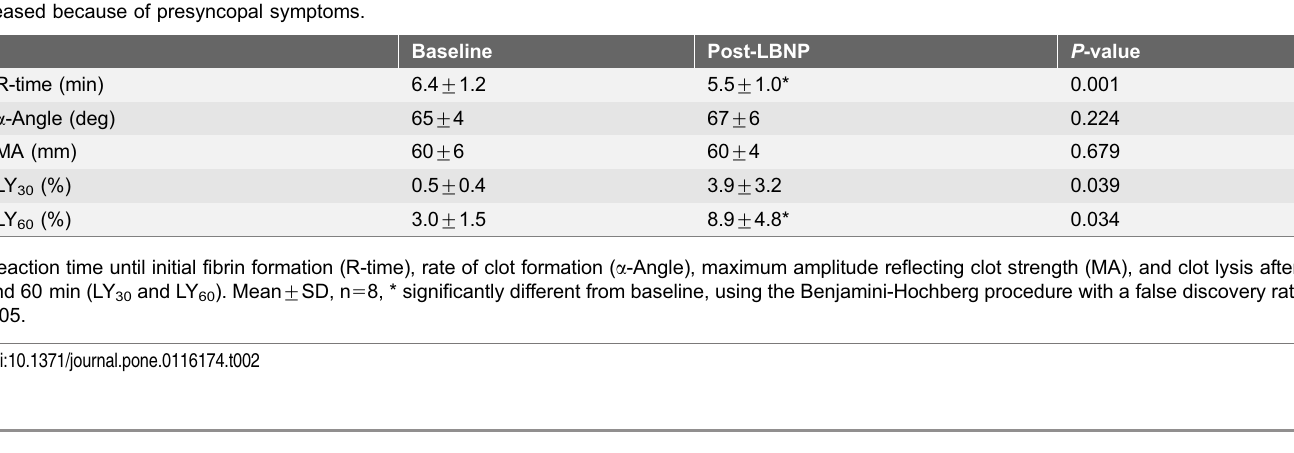
did not exceed their respective reference ranges for healthy subjects (Table 2). In contrast, LBNP did not affect plasma PT and aPTT, but plasma FVIII and vWF:RCo increased by 17 ¡ 12% and 13 ¡ 12%, respectively (Table 3). The mean increase in plasma vWF:Ag did not meet statistical significance; however, plasma vWF:Ag decreased in a single subject with a concomitant decrease in plasma TAT. Plasma Protein C activity, t-PA, and D-dimer increased in all subjects. Platelet count increased in 6 of 7 subjects, whereas other cell counts, although highly variable, increased in all subjects (Table 4). There were no changes in plasma catecholamines or vasopressin, and the increase in plasma renin activity differed greatly between subjects (from 40% to 1370%) (Table 5).